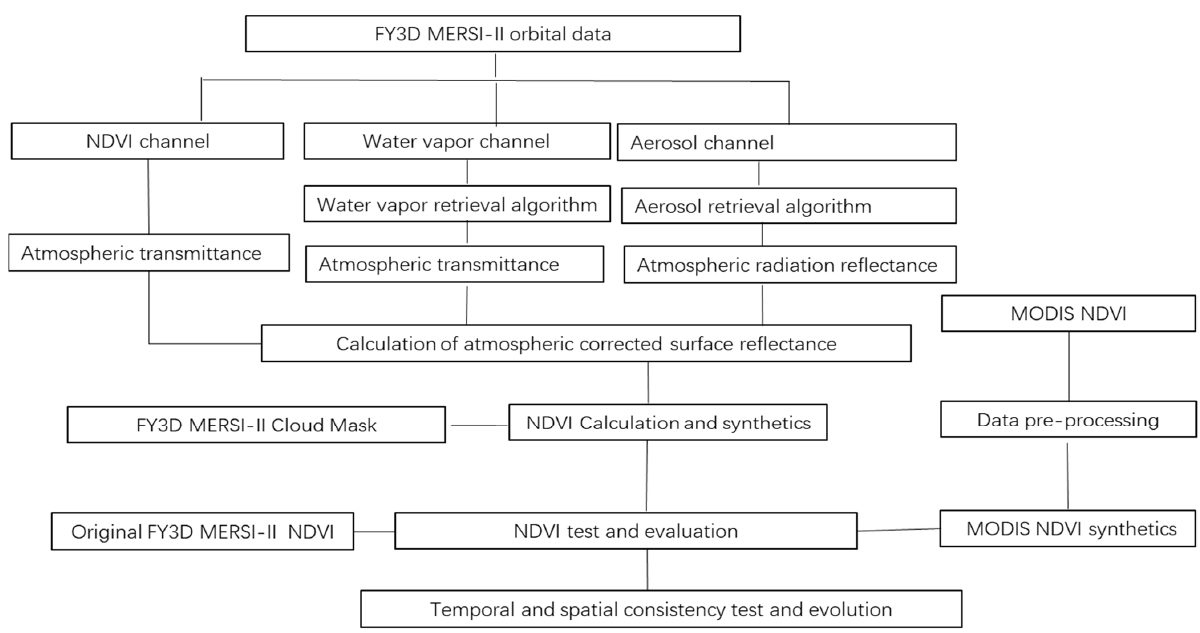
Figure 2. Framework illustrating the bias correction method for the NDVI based on FY-3D MERSI-II.